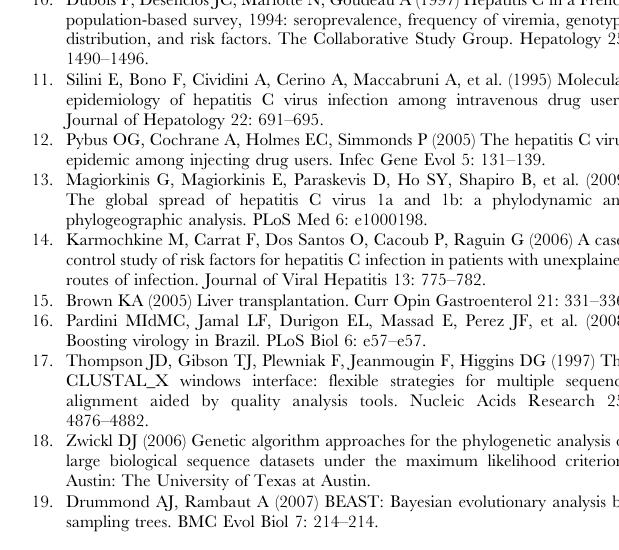
Figure S2 Bayesian skyline plots of the main subtypes found in Sa˜o Paulo: HCV-1a, HCV-3a and HCV-1b. Skyline plots describe the mean change (bold line) in genetic diversity under both the relaxed uncorrelated molecular clock (A, C, E) and strict molecular clock (B, D and F) with values of the 95% of high posterior density (HPD) shown in each case (light line). Figure S3 Relationship between population size in Sa˜o Paulo and viral dynamics. The graph shows the exponential population growth in Sa˜o Paulo State in the period 1920 to 2005 (left y-axis) in millions of people and the increase of viral growth rate (estimated using BEAST) during the same time period (right y-axis). For comparison, the TMRCA for each subtype was obtained also with Path-O-Gen, using the best ML phylogeny inferred with GARLi. A summary of the change in time of HCV growth rates and population size in Sa˜o Paulo is shown in the graph inserted in the upper left of the figure. Dots indicate the growth rate values estimated for each subtype (shown with same